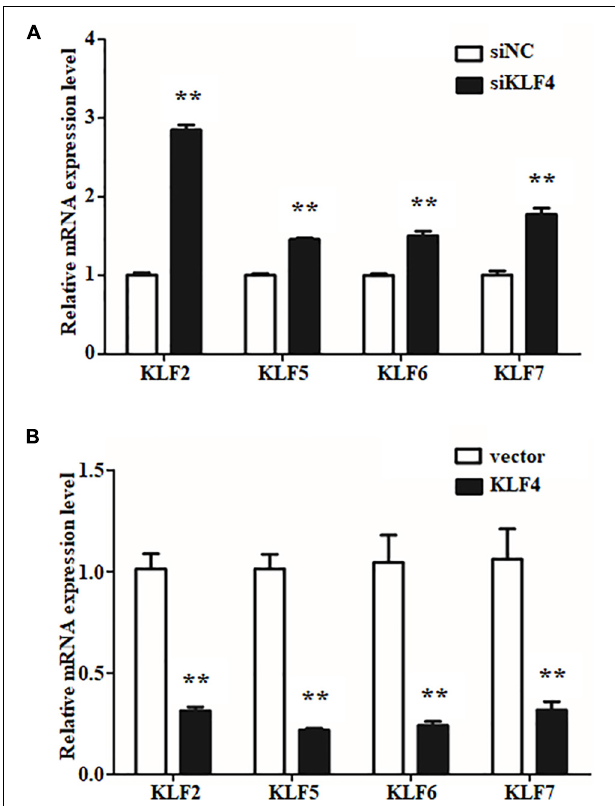
FIGURE 6 | The expressions of other KLF members in gain or loss function of KLF4 intramuscular adipocytes. The mRNA levels of KLF2 , KLF5 , KLF6 , and KLF7 in knockdown (A) and overexpression (B) KLF4 intramuscular adipocytes. * p < 0.05, ** p < 0.01 versus negative control groups. The data are presented as the mean values ± SD. Each experiment was performed at least in triplicate, producing consistent results. * p < 0.05, ** p <